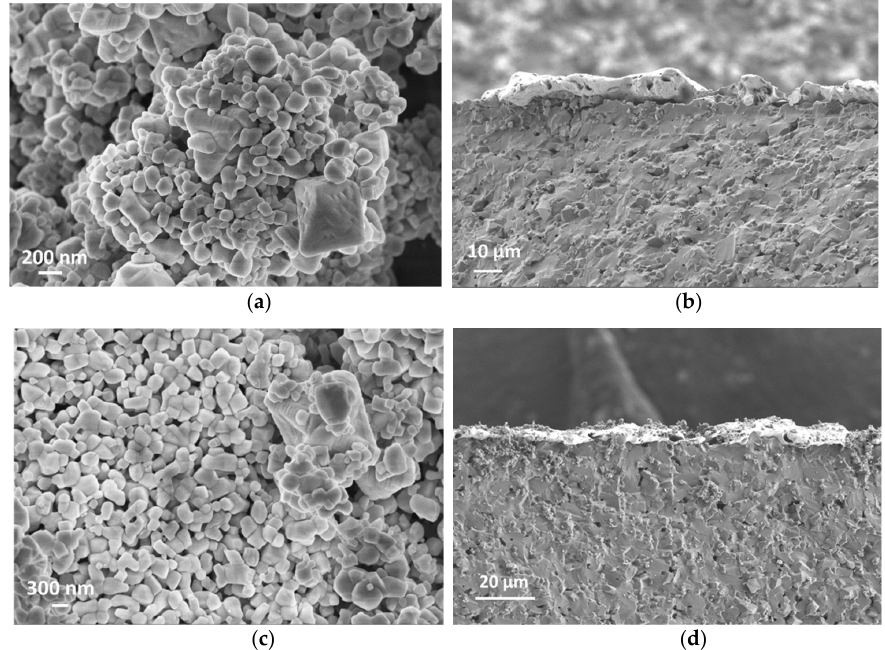
Figure 5. ( a ) Surface topography of S-10 NiO. ( b ) Cross section of S-10 NiO device. ( c ) Surface topography of S-5 NiO. ( d ) Cross section of S-5 NiO device.